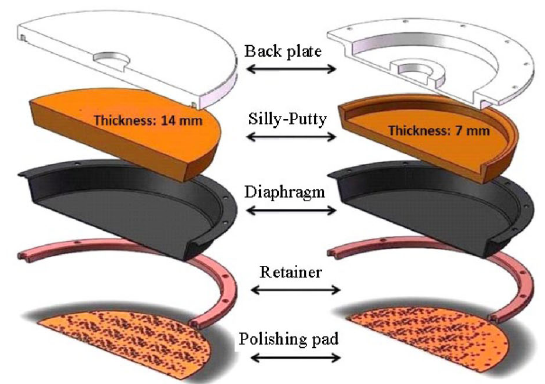
Fig. 4 3D schematic structures of old (left) and new (right) RC-lap structures (exploded and halved).